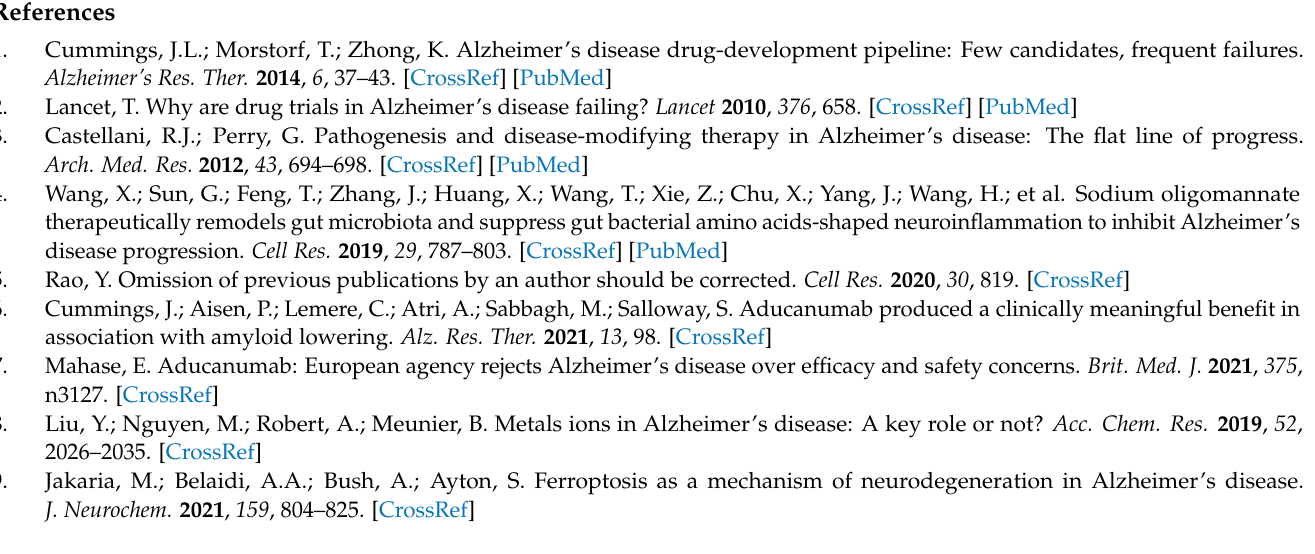
Figure S4: MRM chromatograms of transitions m / z 327.1 → 239.1 representative of TDMQ20 (a) or transition m / z 189.1 → 143.1 representative of IS (b) in (A) blank rat brain homogenate, (B) blank rat brain homogenate spiked with TDMQ20 (10 ng/mL) and IS (8000 ng/mL), (C) rat brain sample 2.0 h after oral administration of TDMQ20 (25 mg/kg). The retention times of TDMQ20 and IS were 3.71 min and 3.86 min, respectively; Table S1: HPLC analyses: Mobile phase composition and gradient elution table. Eluents: (A) 0.1% formic acid in water, (B) methanol; Flow rate: 0.3 mL/min; Column temperature: 40 ◦ C; Injection volume: 1 µ L; Table S2: Mass spectrometry parameters; Table S3: Fragmentation used in MRM mode; Table S4: Intra-day and inter-day accuracy and precision of TDMQ20 (n = 5); Table S5: Extraction recovery and matrix effect of TDMQ20 in rat plasma and brain homogenate; Table S6: Stability data of TDMQ20 in rat plasma and brain homogenate; Table S7: TDMQ20 concentration in plasma (ng/mL) after intravenous administration at 2.5 mg/kg; Table S8: TDMQ20 concentration in plasma (ng/mL) after oral administration at 25 mg/kg; Table S9: TDMQ20 concentration in brain extracts (ng/g) after oral administration at 25